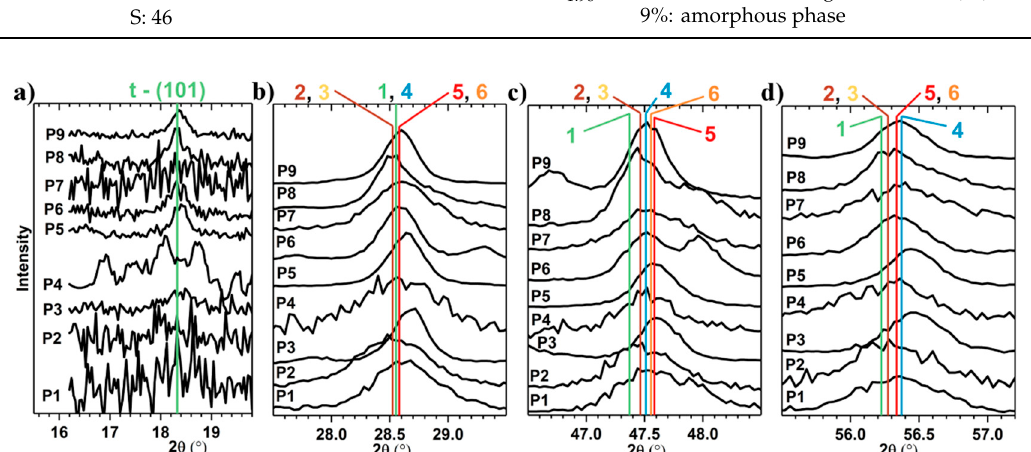
Figure 3. Details of X-ray diffraction patterns of the nine Cu 2 S–ZnS–SnS 2 thin films. The peaks are normalized (greater fluctuations mean peak’s intensity is lower), so, their widths ( β ), at half of the maximum intensity, can easily be compared. ( a ) The peak at 2 θ ~ 18.32°, was the signature of the tetragonal CZTS phase (the lattice plane: (101)). For the peaks at ( b ) 2 θ ~ 28,54°, ( c ) 2 θ ~ 47.5° and ( d ) 2 θ ~ 56.3°, the vertical lines are the positions where the following phases should be present: 1: Cu 2 ZnSnS 4 , tetragonal, I-42m (121), PDF 00-026-0575; 2: Cu 3 SnS 3.6 , tetragonal, I-42m (121), PDF 04-020-